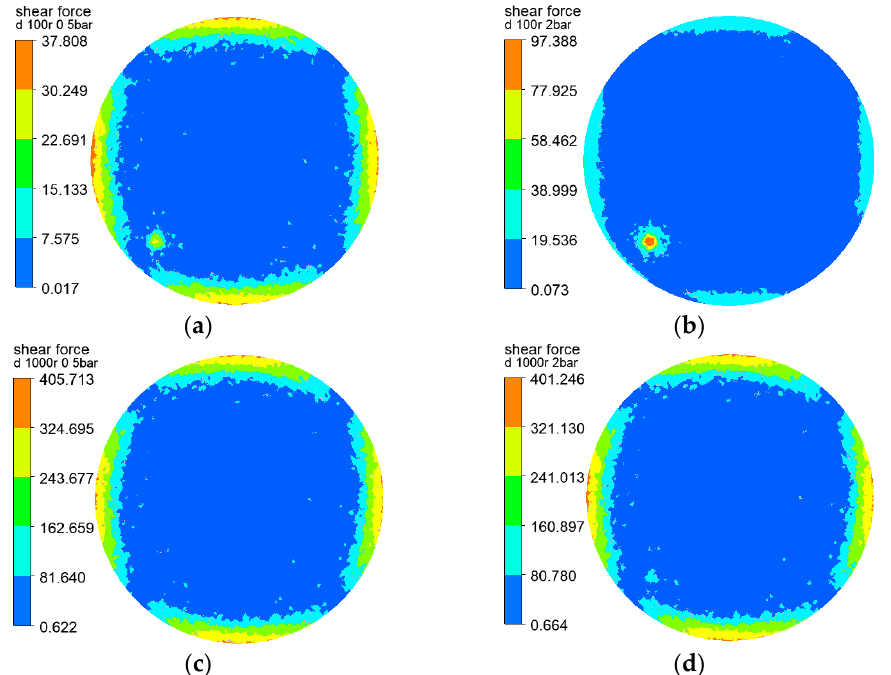
Figure 5. Cloud charts of shear force on the membrane surface when the disk is at different rotating speeds and pressures: ( a ) r = 100 r/min, △ P = 0.5 bar ( b ) r = 100 r/min, △ P = 2 bar ( c ) r = 1000 r/min, △ P = 0.5 bar ( d ) r = 1000 r/min, △ P = 2 bar.